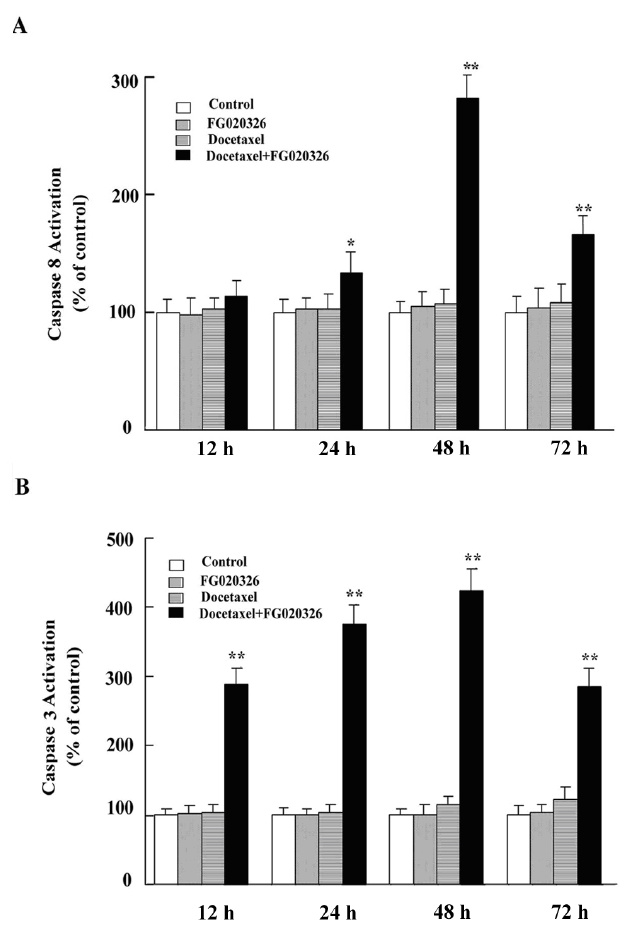
Figure 5. FG020326 sensitized caspase-8 ( A ) and -3 ( B ) activation induced by